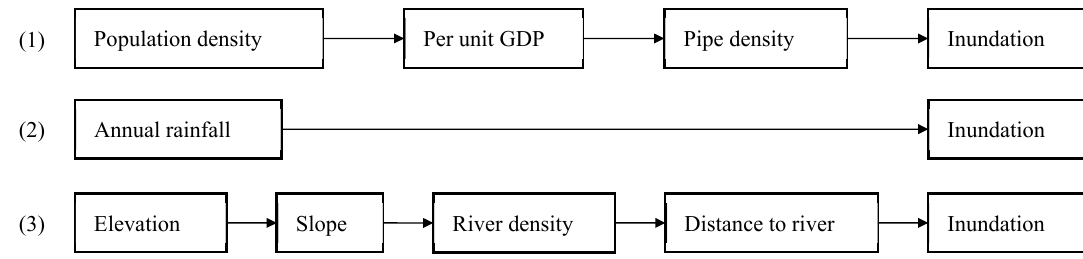
Figure 8. Key disaster-causing factors chains.